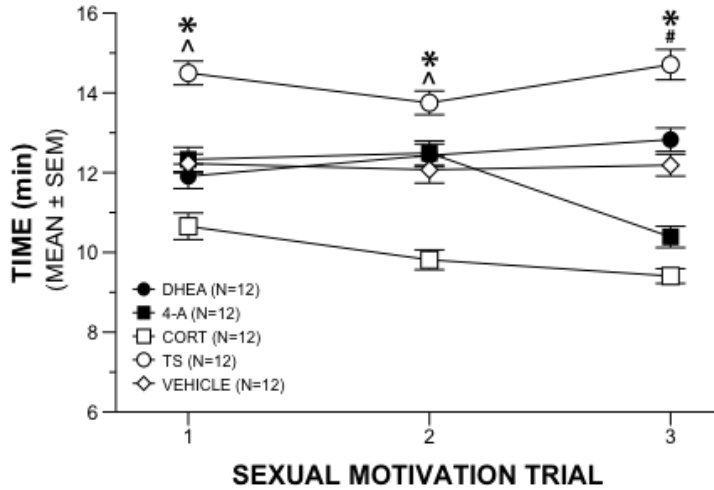
Figure 1. Sexual Motivation Behavior. Mean (±SEM) time gonadally intact male rats given chronic steroid or vehicle supplement spent near estrous female during three weeks of 20-min sexual motivation trials. ( * ) TS significantly different from all other groups; ( ^ ) CORT significantly different from all other groups; (#) CORT significantly different from all other groups except